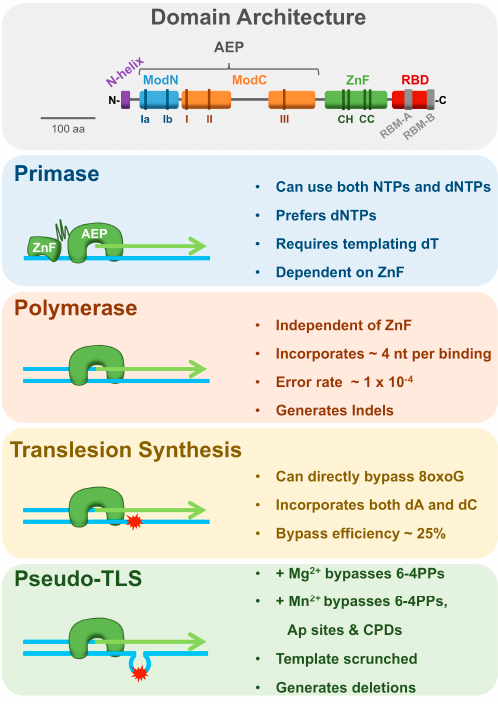
Figure 1. Domain architecture and catalytic activities of primase-polymerase (PrimPol). The domain architecture of PrimPol is depicted in the top panel. A helix ( purple ) located at the N-terminus is connected to ModN by a flexible linker and contacts the DNA major groove. ModN ( blue ) and ModC ( orange ) comprise the archaeo-eukaryotic primase (AEP) domain and contain motifs Ia, Ib, I, II, and III, required for template binding and catalytic activity. The zinc finger (ZnF) ( green ) contains three conserved cysteines and a histidine which coordinate a zinc ion and are required for primase, but not polymerase, activity. The replication protein A (RPA) binding domain (RBD) ( red ) containing RPA binding motif-A (RBM-A) and RBM-B ( grey ) is located at the C-terminus. A 100 amino acid (aa) scale bar is shown to the right. The catalytic activities of PrimPol are displayed below.